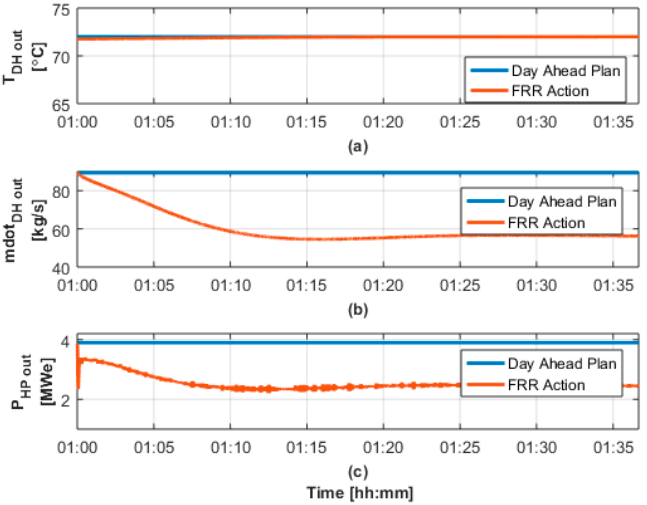
Figure 17. HP’s main variables during FRR action: ( a ) temperature of forwarded water into DH network; ( b ) hot water’s mass-flow to DH network and ( c ) electrical power consumption of HP.